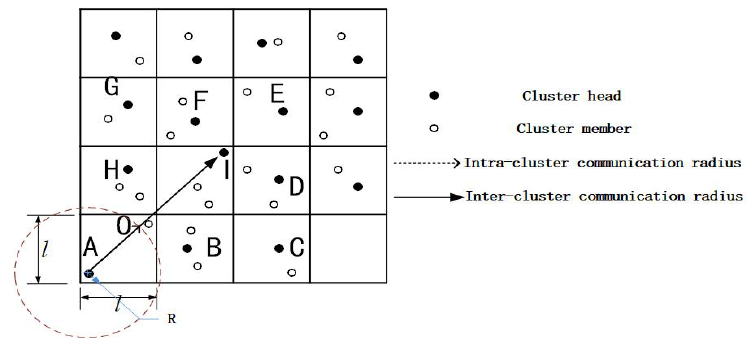
Figure 3. Communication radius of the node.